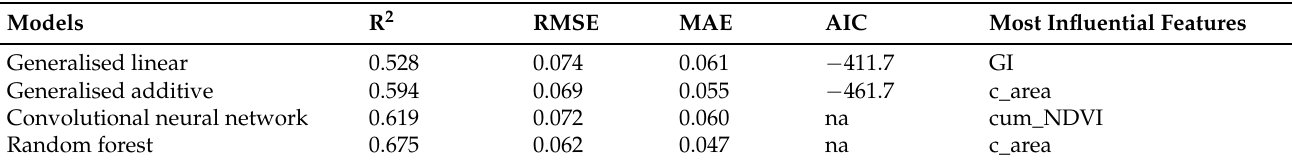
Table 2. Accuracy of various models used to predict the k c using leave-one-out fit-control. Note the accuracy metrics were derived by applying the model to the unseen testing dataset. Note: AIC in the table heading is an abbreviation of the Akaike information criterion.